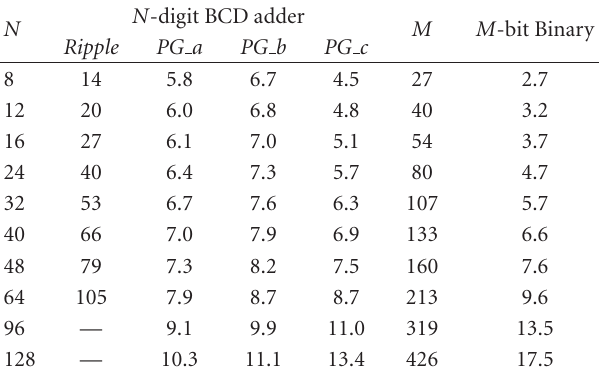
Table 1: Time delays (nsec) for di ff erent adders in Virtex-4 -11. N -digit BCD N